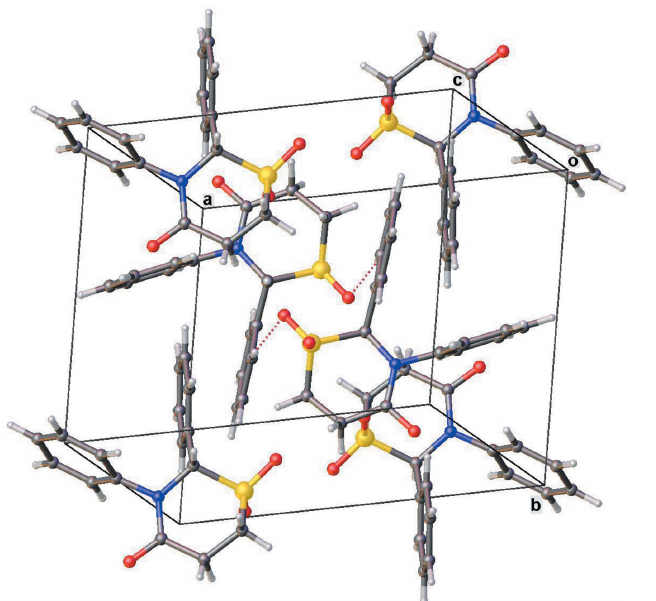
Figure 4 Crystal packing diagram for 1 showing intermolecular pairs of C—H (cid:2)(cid:2)(cid:2) O hydrogen